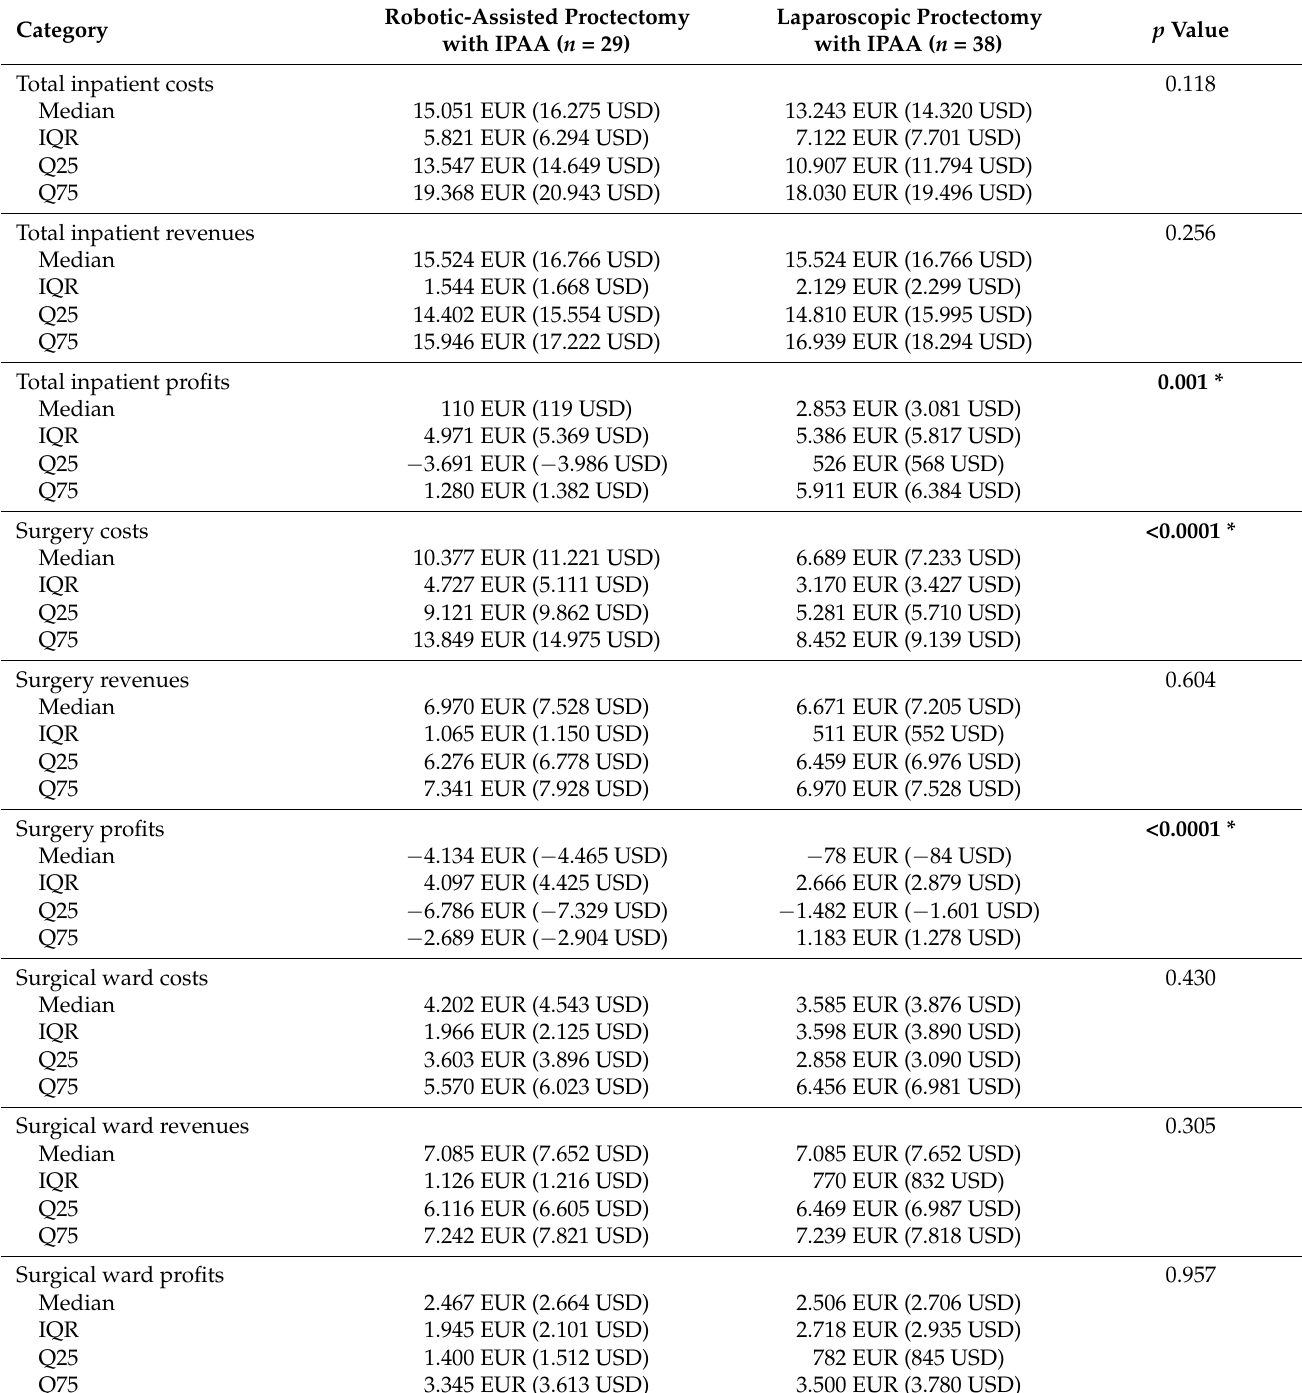
Table 6. Detailed in-hospital Cost